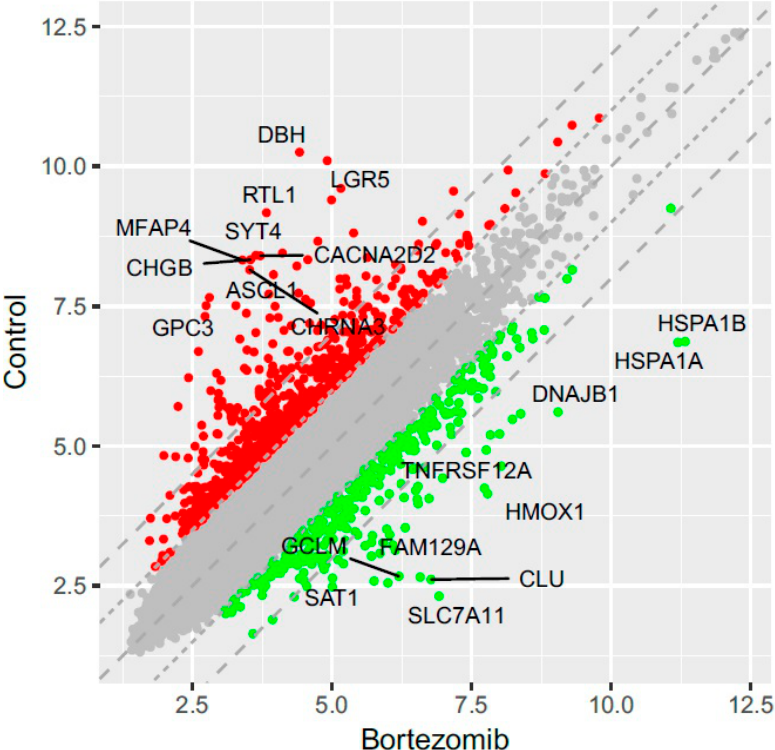
Figure 2. The scatterplot of global gene expression in bortezomib-treated SH-SY5Y cells compared to the control cells. Red points show downregulated genes (at least 2-fold change, p < 0.05), green points show upregulated genes (at least 2-fold change, p < 0.05). The graph also comprises the names of genes with the largest change in expression.